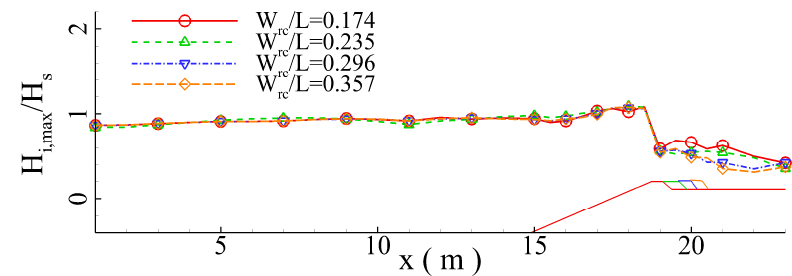
Figure 57. Space distribution of the local maximum wave height.